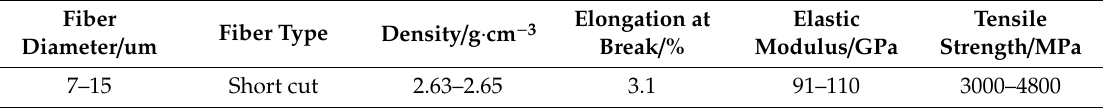
Table 1. Physical and Mechanical Properties of Basalt